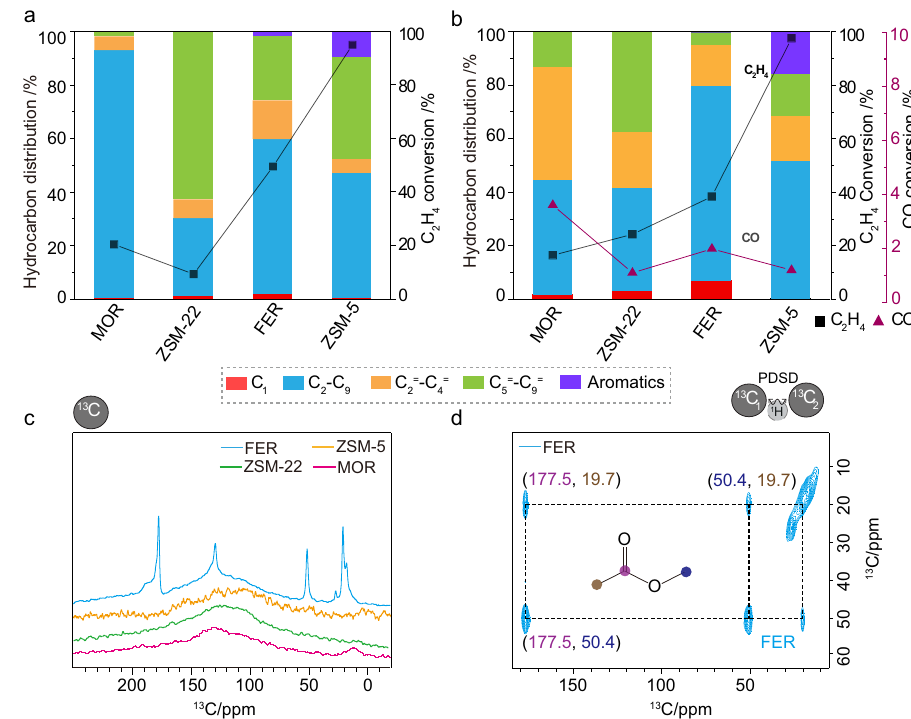
Fig. 6 A summary of control experiments. The catalytic performance of the standalone zeolite-mediated conversion of a ( 12 C)ethylene and b fully enriched 13 CO and ( 12 C)ethylene at 30 bar, 375 °C, and 10,000mL · g − 1 · h − 1 under hydrogen-rich environment at a time on stream of 2 h (i.e., without any Fe 2 O 3 @KO 2 phase) (also see Supplementary Fig. 14). c 1D 13 C direct excitation MAS solid-state NMR spectra on all four zeolites, collected after the control experiments involving both 13 CO and 12 C 2 H 4 in the reactant feed. Due to the selective isotope enrichment of 13 CO in the reactant feed, DE experiments can only be correlated to the 13 CO consumption during catalysis. The broad nature of DE experiments (except FER) implying that 13 CO predominantly converted to the rigid species only (also see Supplementary Figs. 15 and 16 for details, MAS magic angle spinning). d The spectral identi fi cation of methyl acetate was observed on the postreacted FER zeolite via 13 C- 13 C correlation spectra, where the carbons were polarized through direct excitation and 13 C- 13 C mixing was achieved through proton-driven spin diffusion (PDSD) (also see Supplementary Fig. 17). The respective full-range spectra, as well as experimental details, are included in Supplementary